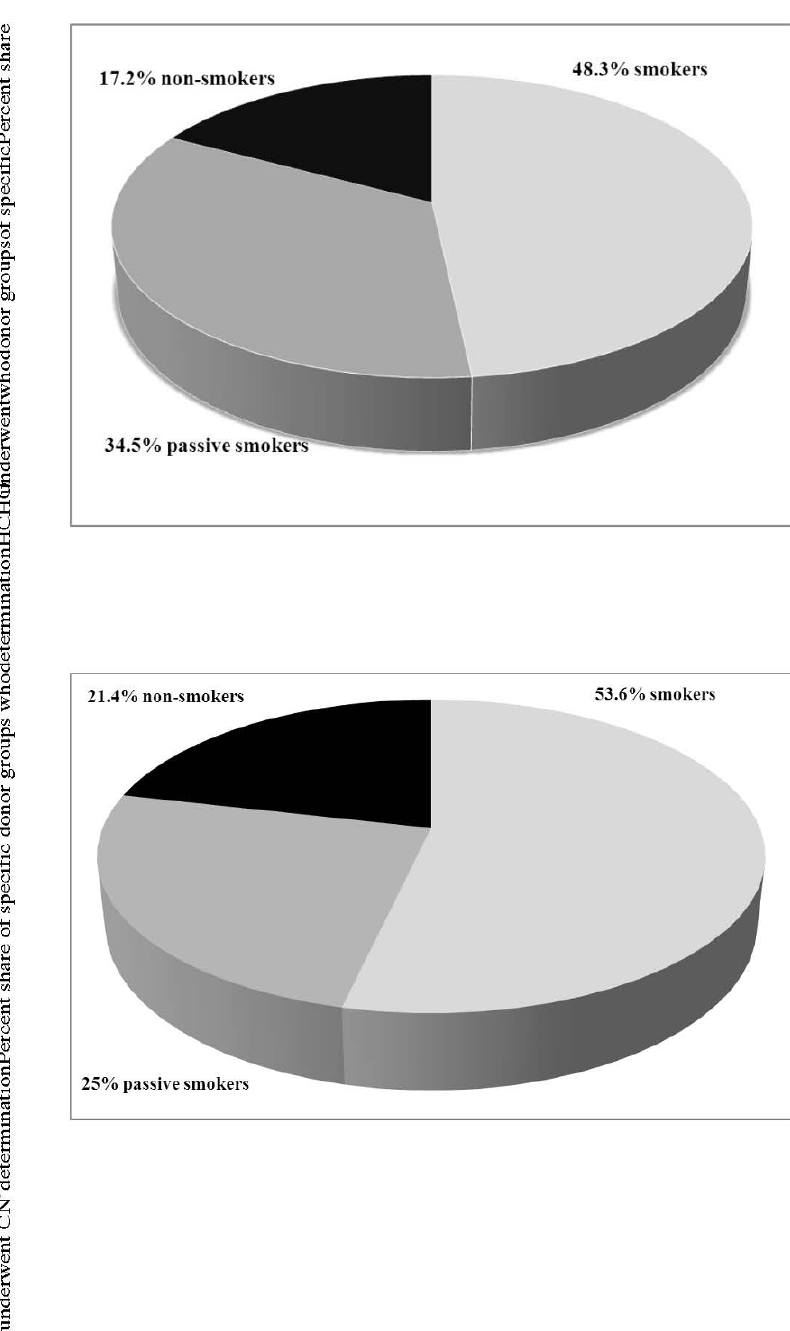
Figure 2. Percent share of sample donors exposed to ETS components at varying